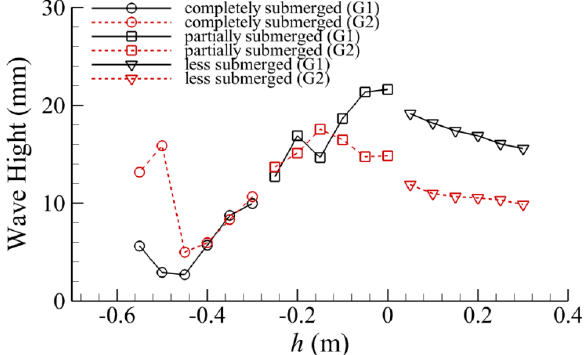
Figure 9. The change of maximum wave height with falling height.